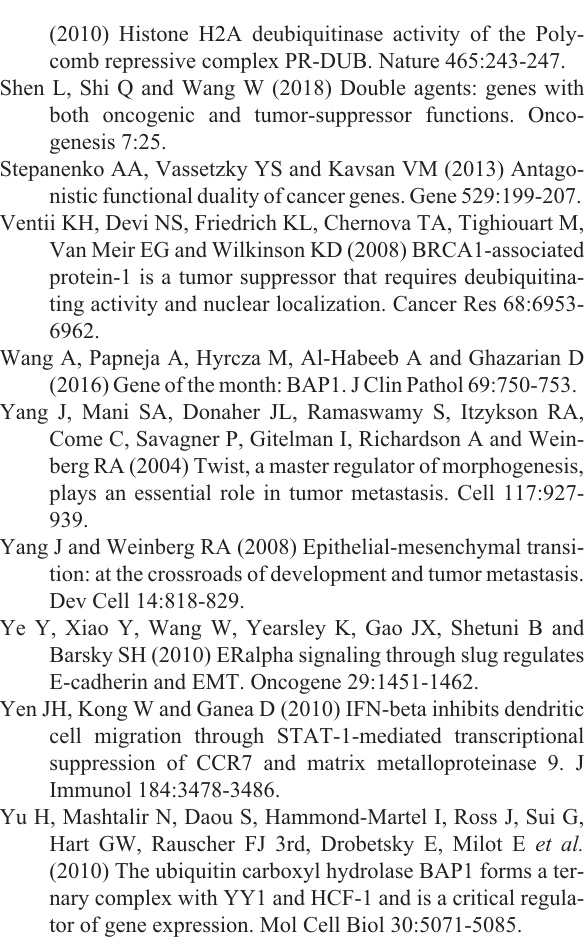
Figure S1 – The expression of apoptotic genes is not affected upon knockdown of BAP1 in prostate cancer cells. Table S1 – Primers used for apoptotic genes in real-time